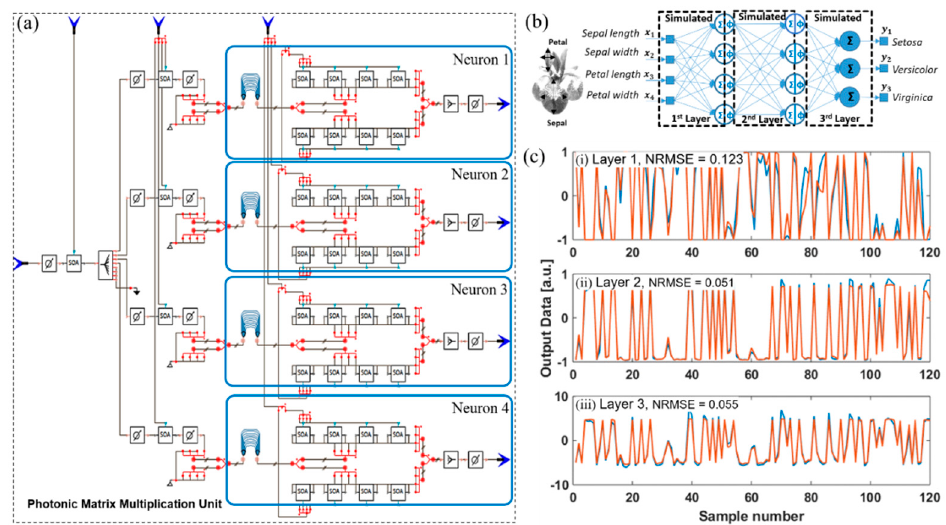
Figure 5. ( a ) The simulation structure of one layer of neurons; ( b ) Trained 3-layer deep neural network (DNN) employed to solve the iris flower classification. ( c ) Output data obtained from Neuron 1 at (i) Layer 1, (ii) Layer 2, and (iii) Layer 3, with calculated errors between simulated computation (blue line) and the expected computation (red line), resulting in errors of 0.123, 0.051, and 0.055, respectively.